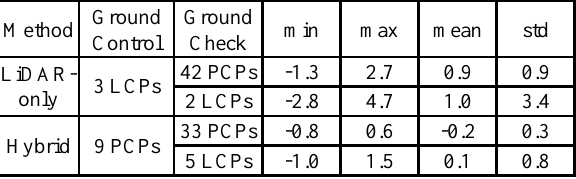
Table 1: Elevation differences of LiDAR point cloud to signalized targets. All measures are given in cm.